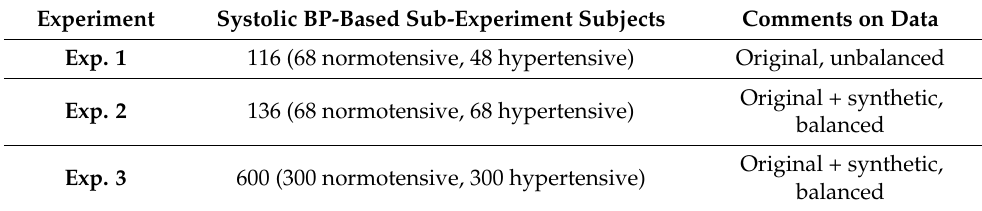
Table 5. Stage 1. Systolic BP-based sub-experiment.